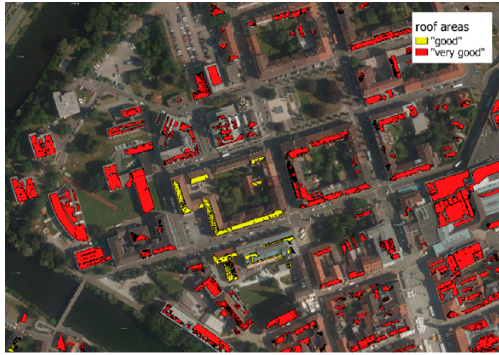
Figure 3. Example of suitable roof areas, including the classification “very good” and “good” based on data from the solar roof register [15].